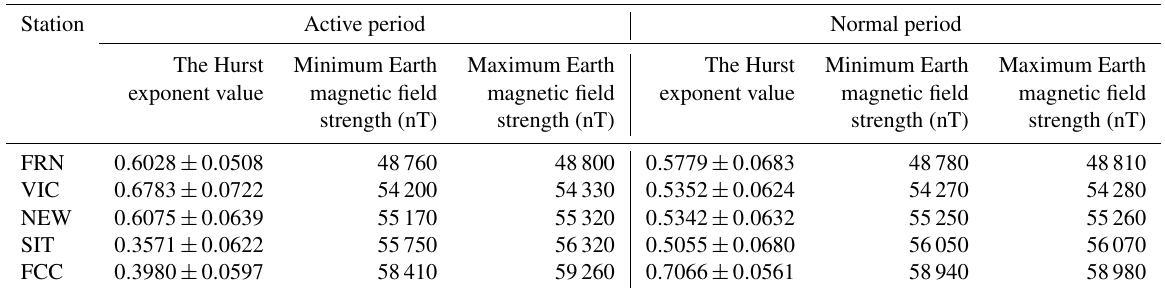
Figure 7. Periodogram for the midlatitude region during the active period and normal. Table 4. The Hurst exponent as well as the maximum and minimum strength of the Earth’s magnetic field during the geomagnetic storm (active period) and normal period for station in the midlatitude